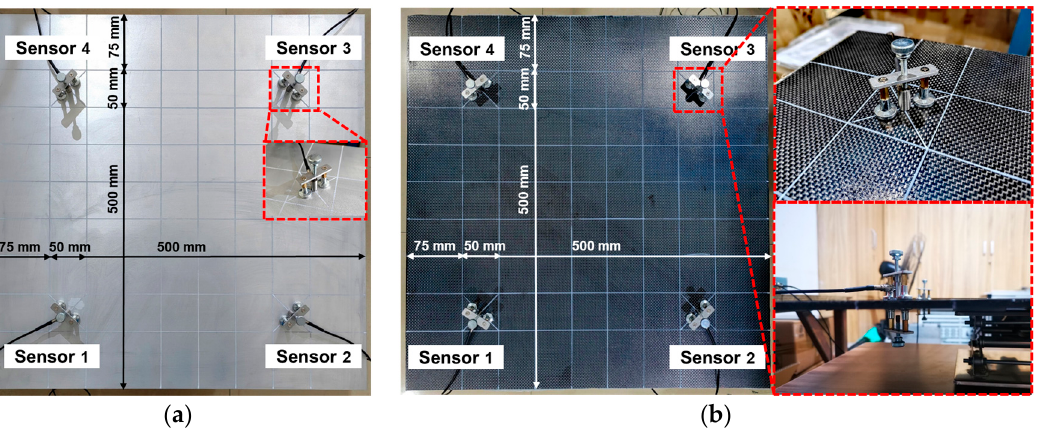
Figure 3. Experimental setup for the area location of acoustic emission sources: ( a ) aluminum alloy plate; ( b ) CFRP composite laminates.